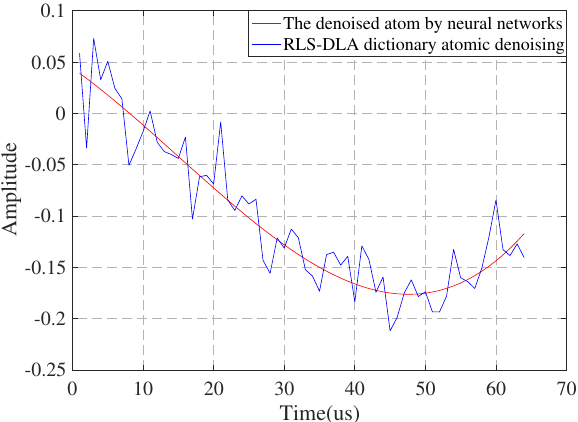
Figure 6. Comparison of neural network and RLS-DLA